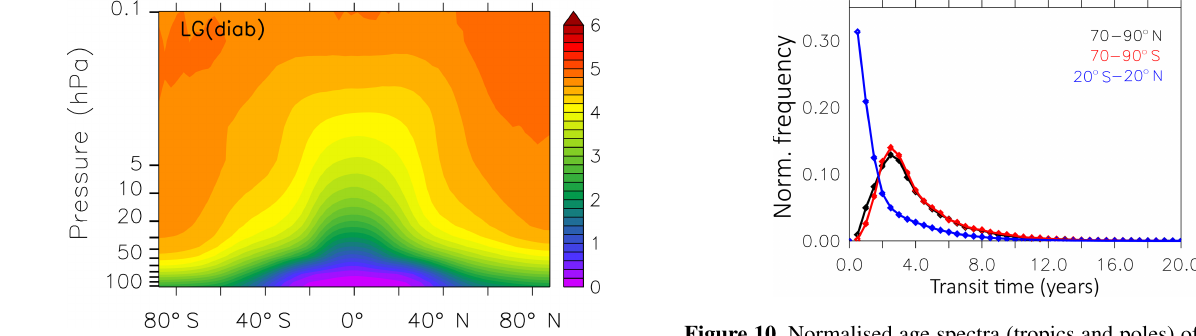
Figure 8. Zonal mean AoA (in years) from the SF 6 _AoA tracer in the LG(diab) simulation.